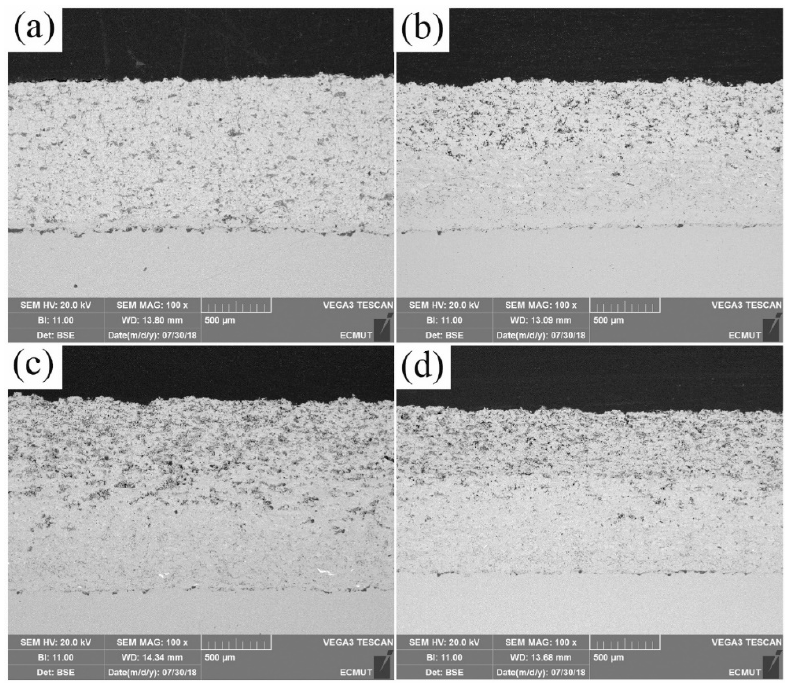
Figure 22. SEM images of the sample cross-section: ( a ) TTBC ( b ) FGTTBC ( c ) FGTTBC-P ( d ) FGTTBC-PG [147] .